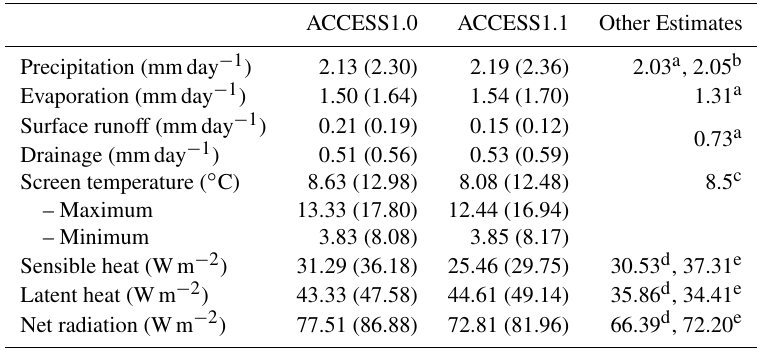
Table 2. Water and energy budget components, averaged over all land surfaces for ACCESS1.0 and ACCESS1.1 compared to estimates from other sources. (Values in parentheses are for all land excluding Antarctica.)